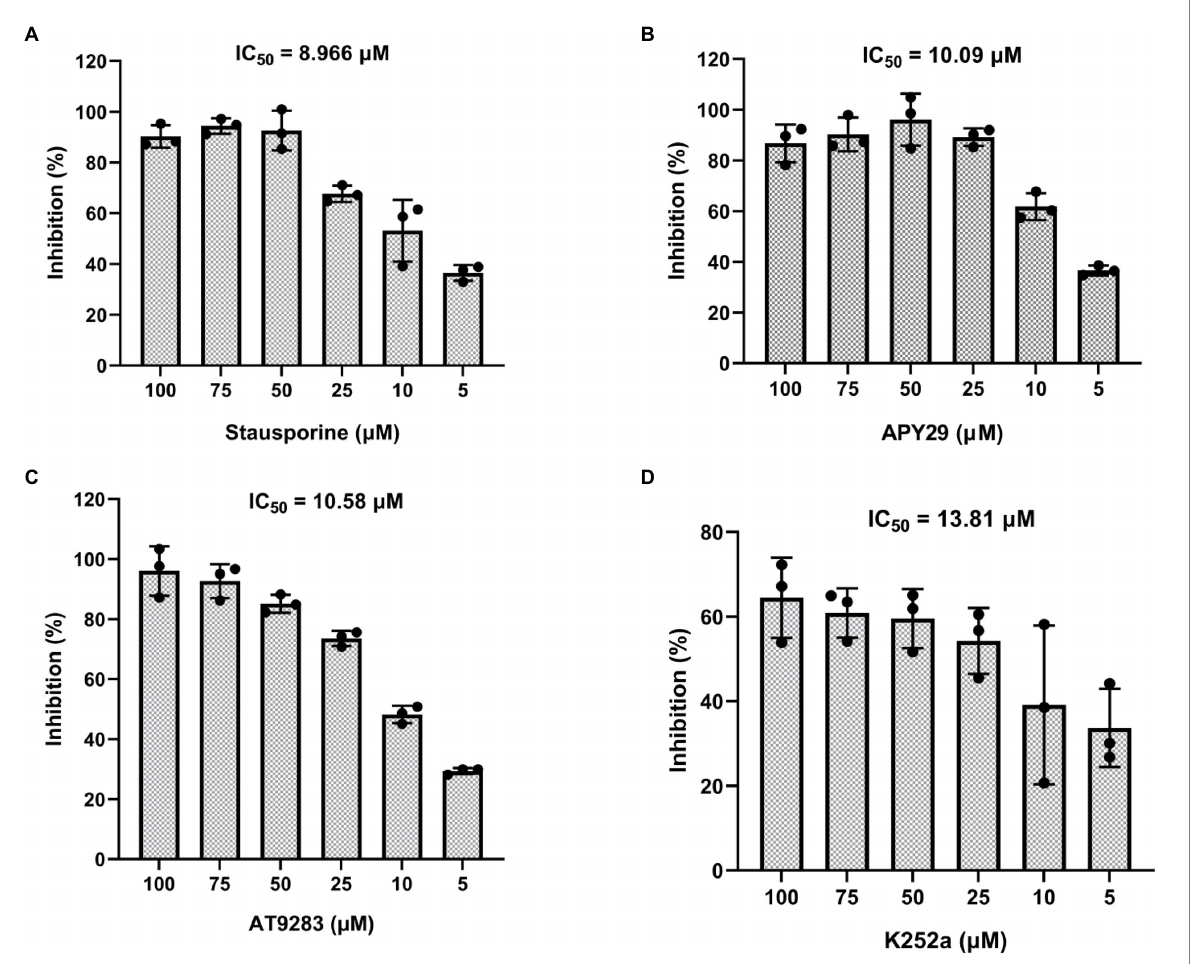
FIGURE 6 IC 50 of inhibitors against ssSTK. Staurosporine (A) , APY29 (B) , AT9283 (C) and K252a (D) at 5, 10, 25, 50, 75, 100 μ M and ssSTK were co-incubated at 37 ° C for 30 min, respectively. Next, the remaining ATP levels of the sample were measured by chemiluminescence technology to determine autophosphorylation levels of ssSTK. The experiments were carried out two times independently under the same